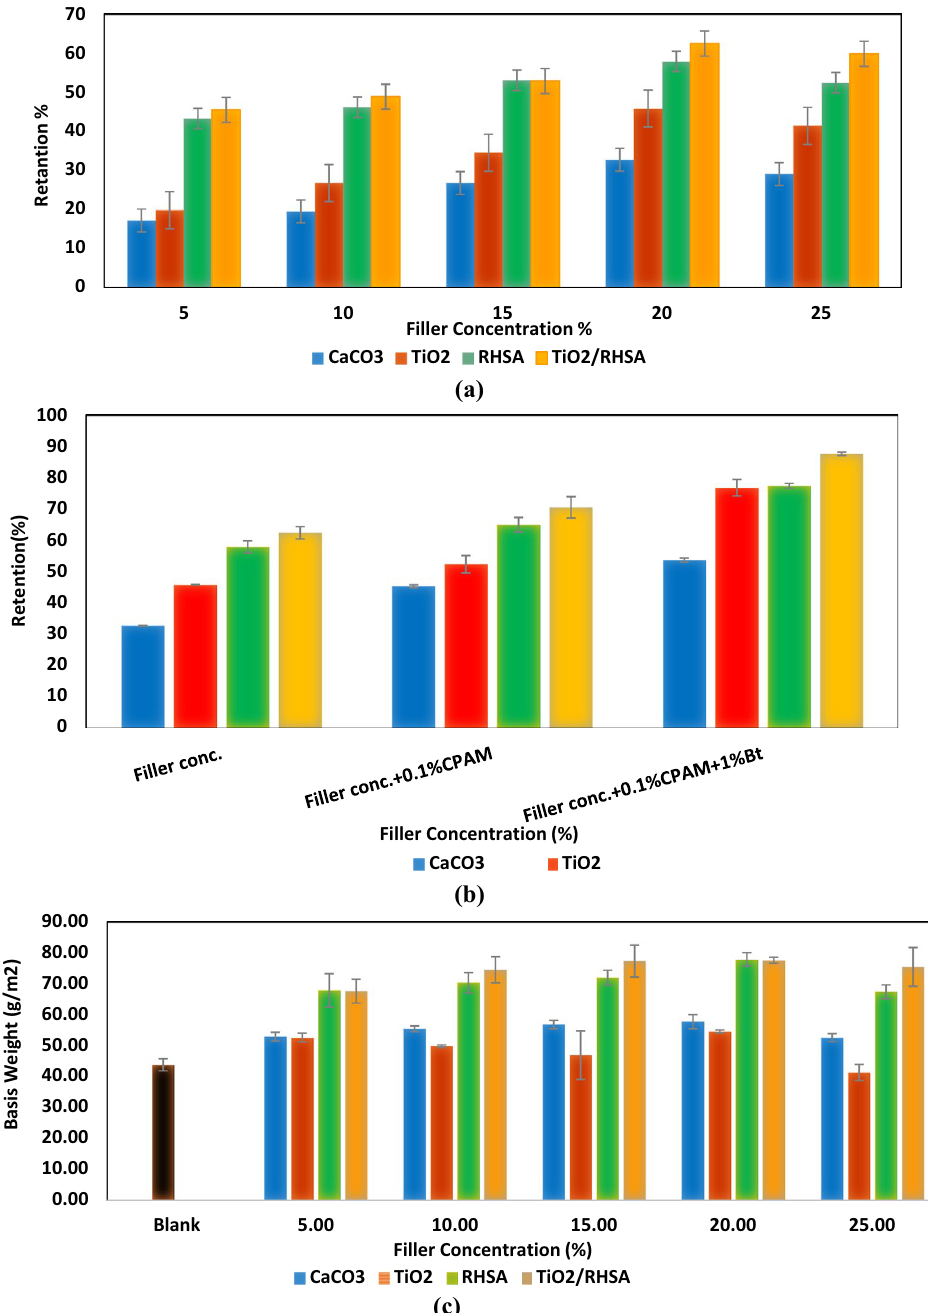
Figure 2. Effect of filler concentration, retention aid addition on retention percent ( a , b ), basis weight ( c , d ) and bulk density ( e , f ) of paper